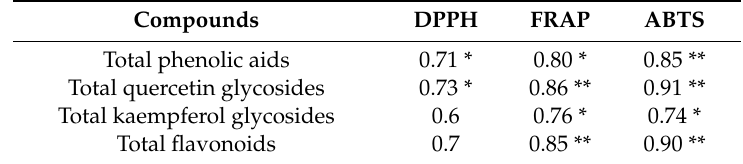
Table 1. Pearson correlation coe ffi cients between phenolic contents in C. paliurus leaves and antioxidant activities of C. paliurus leaf extracts ( n = 21).